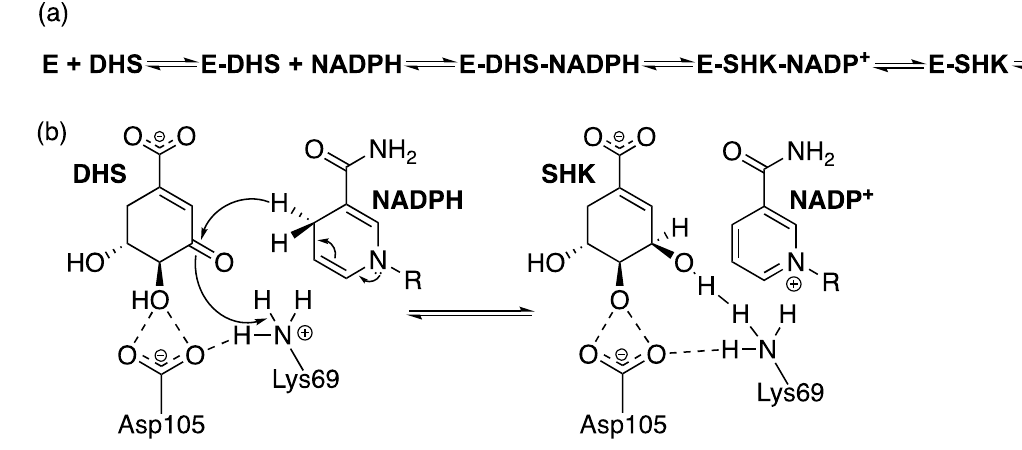
Figure 9. Mt SD ( a ) kinetic and ( b ) chemical mechanisms. R represents the ribose, adenosine diphosphate and 2 ′ -phosphate moieties of NADPH.